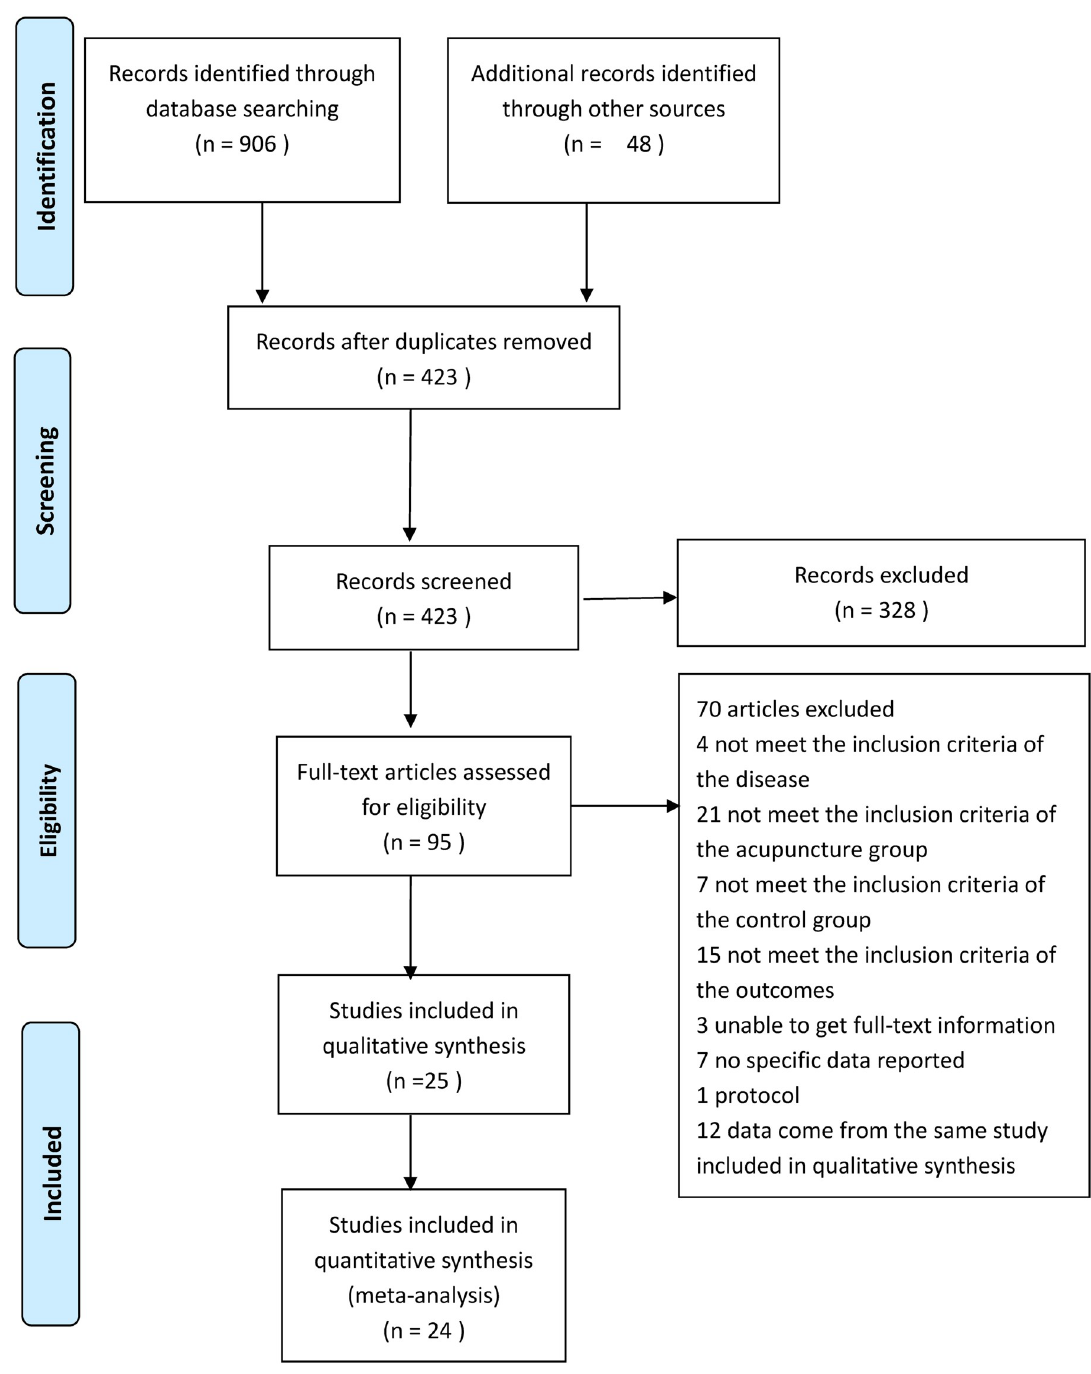
Fig 1. PRISMA flow